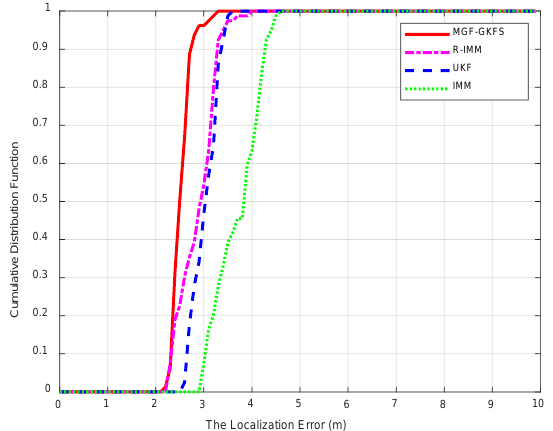
Figure 5. The cumulative distribution function (CDF) when non-line of sight (NLOS) errors obey N ( 2,4 2 ) .